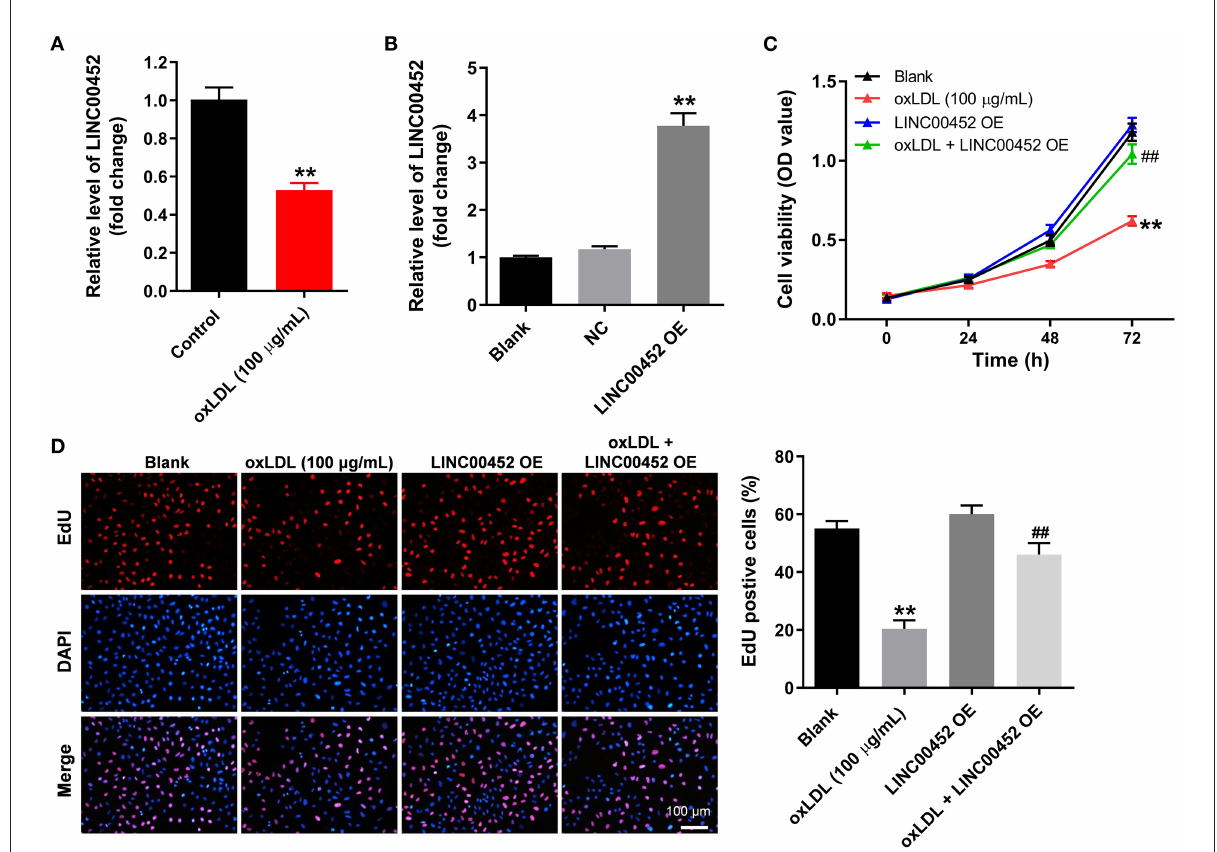
FIGURE1 LINC00452 overexpression reverses oxLDL-induced growth inhibition of HUVECs. (A) HUVECs were treated with oxLDL (100 µ g/mL) for 24h. RT-qPCR was performed to detect the expression of LINC00452 in HUVECs. (B) HUVECs were transfected with pcDNA3.1-NC or pcDNA3.1-LINC00452 using Lipofectamine 2000 for 24h. RT-qPCR was performed to detect the efficiency of transfection. (C,D) HUVECs were treated with oxLDL or/and pcDNA3.1-LINC00452. CCK8 and EdU assays were performed to evaluate the viability and proliferation of HUVECs, respectively. ** P < 0.01 compared to the control group. ## P < 0.01 compared to the oxLDL (100 µ g/mL) group, n =